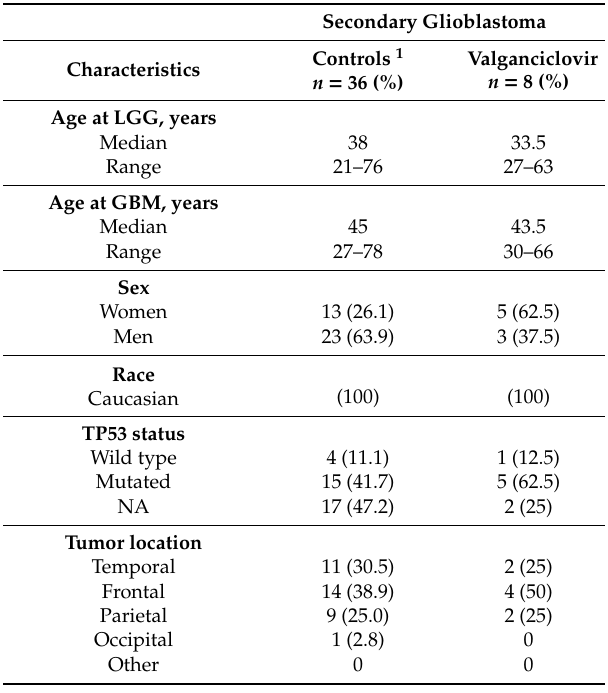
Table 1. Demographic and clinical